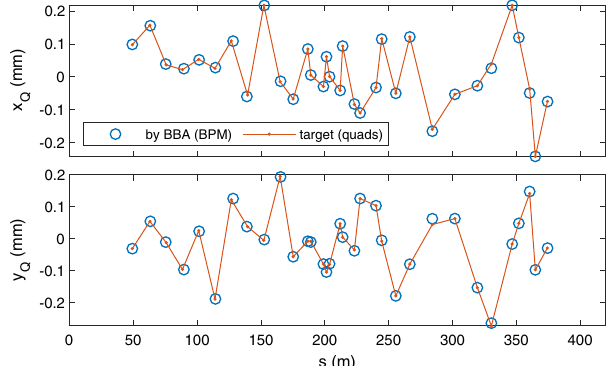
FIG. 6. The quadrupole center offsets registered by BPMs through the PBBA method are compared to the target values at the quadrupole locations, for all quadrupoles in the LTU